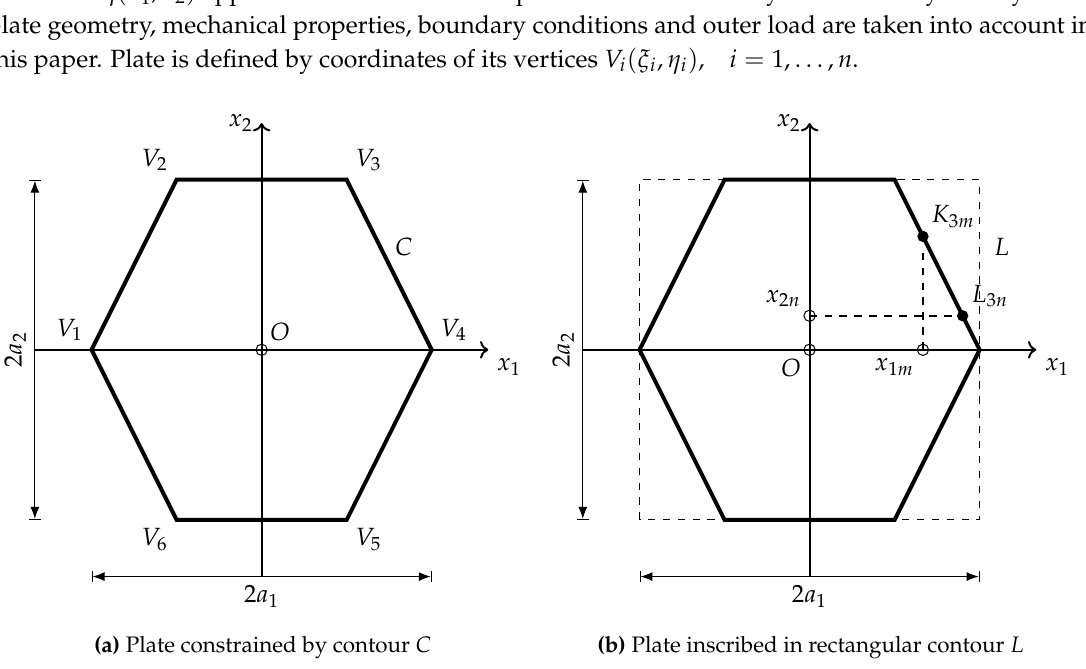
Figure 1. Scheme of the symmetrical